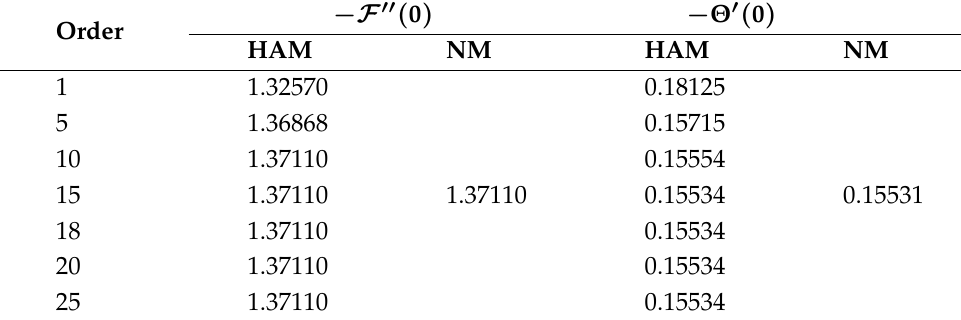
Table 3. HAM order and numerical value of MWCNTs.